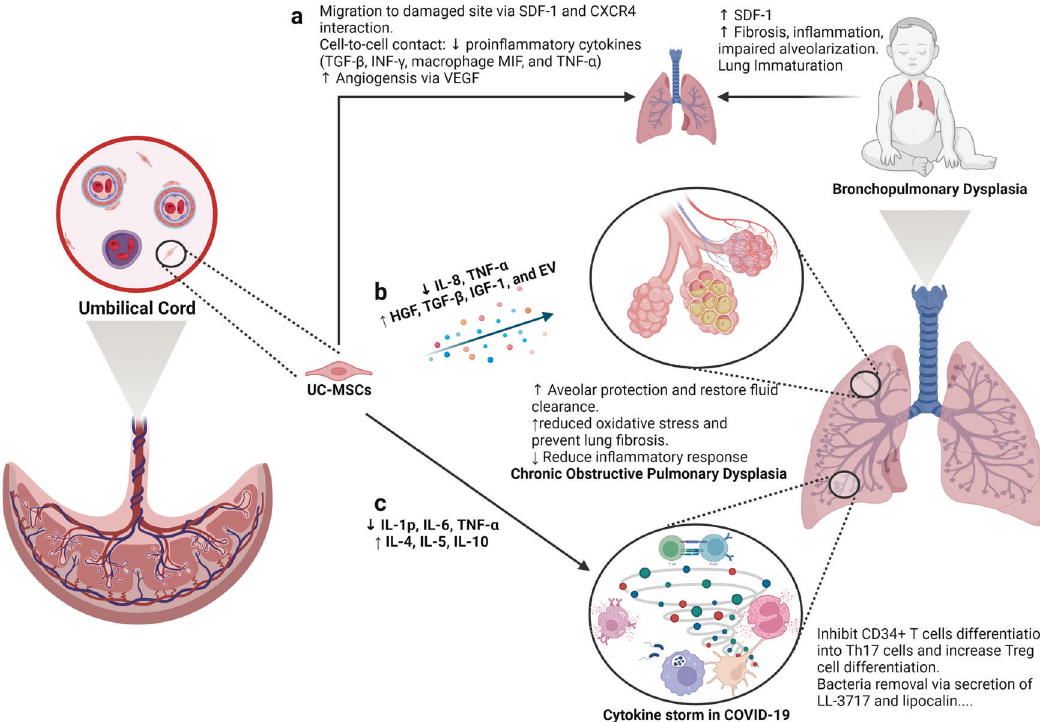
Fig. 5 Umbilical cord-derived mesenchymal stem cells (UC-MSCs) are good candidates for the treatment of pulmonary diseases. a Lung immaturity and fi brosis are the major problems of patients with bronchopulmonary dysplasia and lead to increased levels of SDF-1, the development of fi brosis, the induction of the in fl ammatory response, and the impairment of alveolarization. UC-MSCs are attracted to the damaged lung via the chemoattractant SDF-1, which is constantly released from the immature lung via SDF-1 and CXCR4 communication. Moreover, UC-MSCs reduce the level of proin fl ammatory cytokines (TGF- β , INF- γ , macrophage MIF, and TNF- α ) via a cell-to-cell contact mechanism. The ability of UC-MSCs to produce and secrete VEGF also involves in the regeneration of the immature lung through enhanced angiogenesis. b Upon an exacerbation of chronic obstructive pulmonary disease (COPD), UC-MSCs respond to the surrounding stimuli by reducing IL-8 and TNF- α levels, resulting in the inhibition of the in fl ammatory response but an increase in the secretion of growth factors participating in the protection of alveoli, fl uid clearance and reduced oxidative stress and lung fi brosis, including HGF, TGF- β , IGF-1, and exosomes. c In a similar manner, UC-MSCs prevent the formation of cytokine storms in coronavirus disease 2019 (COVID-19) by inhibiting CD34 + T-cell differentiation into Th17 cells and enhancing the number of regulatory T cells. Moreover, UC-MSCs also have antibacterial activity by secreting LL-3717 and lipocalin. Figure was created with